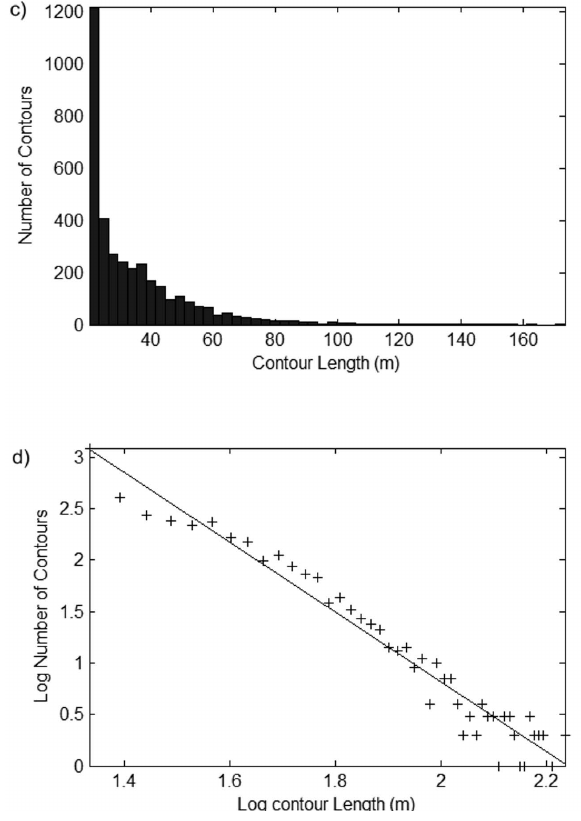
Fig. 1c, d. Histogram and log-log histogram of the lengths of the edge contours obtained from the gravity response from 10000sources at a depth of 5m. A fitted power–law distribution is shown as a solid